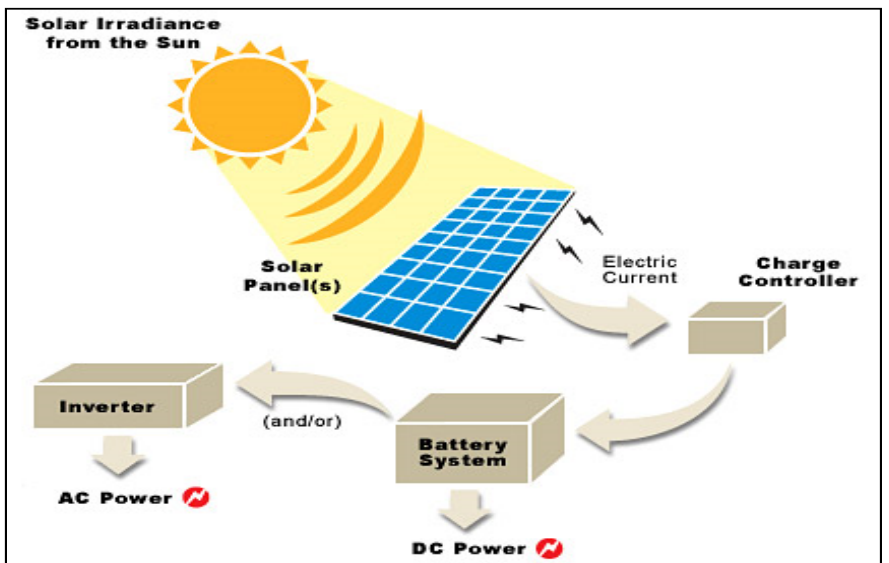
Figure 30. Schematic illustration for obtaining AC power from solar panels.